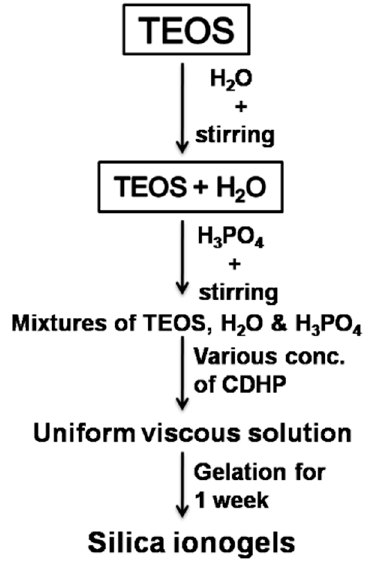
Scheme 1. Simple schematic representation of silica ionogel preparation.